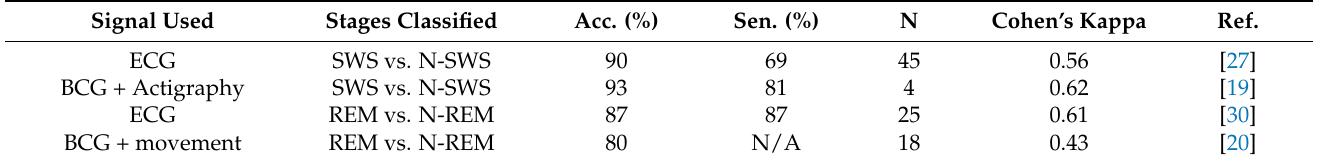
Table 1. Classification performance metrics based on HRV features acquired from ECG and BCG